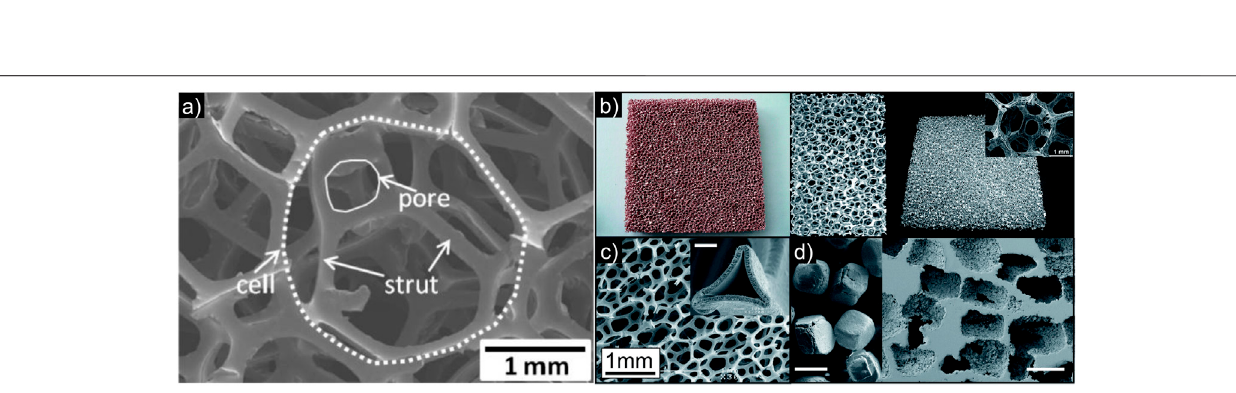
Frontiers in Chemical Engineering |